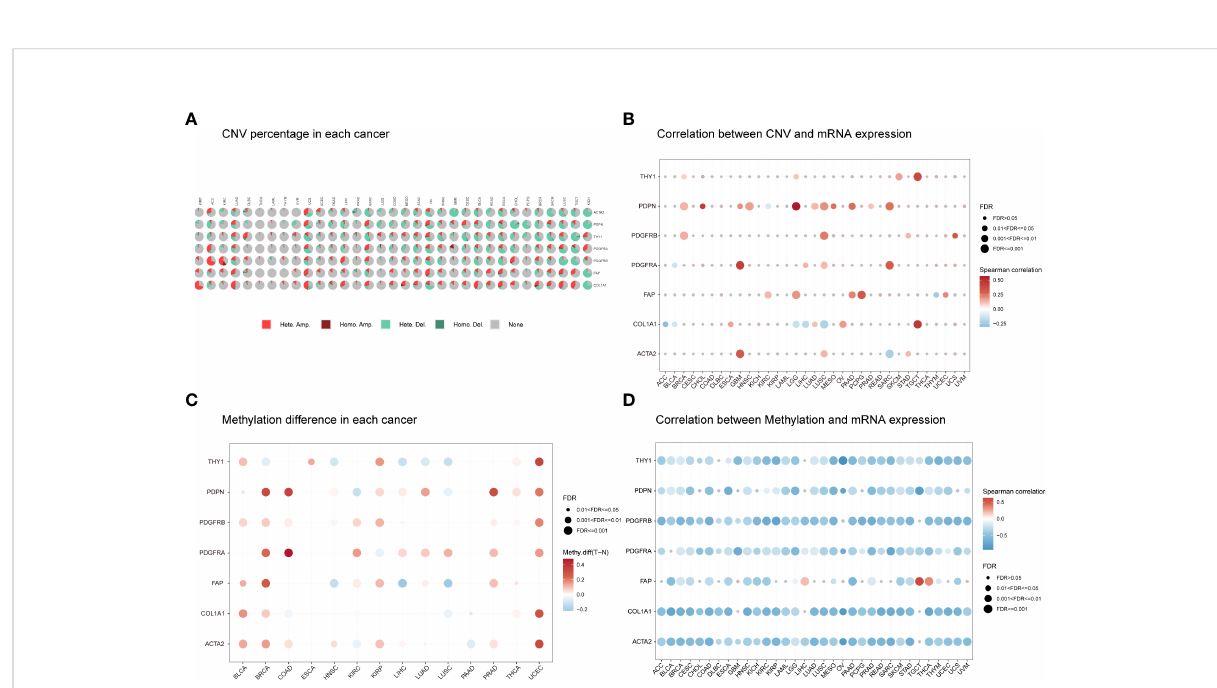
FIGURE 2 The CNV distribution and methylation levels of seven CAF markers in pan-cancer. (A) Pie charts illustrating the proportion of multiple CNV types for each marker across each cancer type. The color represents different CNV types. Hete Amp, heterozygous ampli fi cation; Hete Del, heterozygous deletion; Homo Amp, homozygous ampli fi cation; Homo Del, homozygous deletion; None, no CNV. (B) The correlation between CNV and mRNA expression for each marker in the selected cancer types. (C) Marker gene methylation status between tumor and normal samples in the selected cancer types. The red and blue dots represent increased and decreased methylation in tumors compared to normal tissues, respectively. The darker the color, the larger the methylation difference. (D) Correlation between methylation and mRNA expression for each marker in the selected cancer types. The red and blue dots represent positive and negative correlations, respectively. Gray dots indicate no signi fi cant correlation. Darker colors indicate stronger correlations. The dot size represents statistical signi fi cance (larger dot sizes indicate increased statistical signi fi